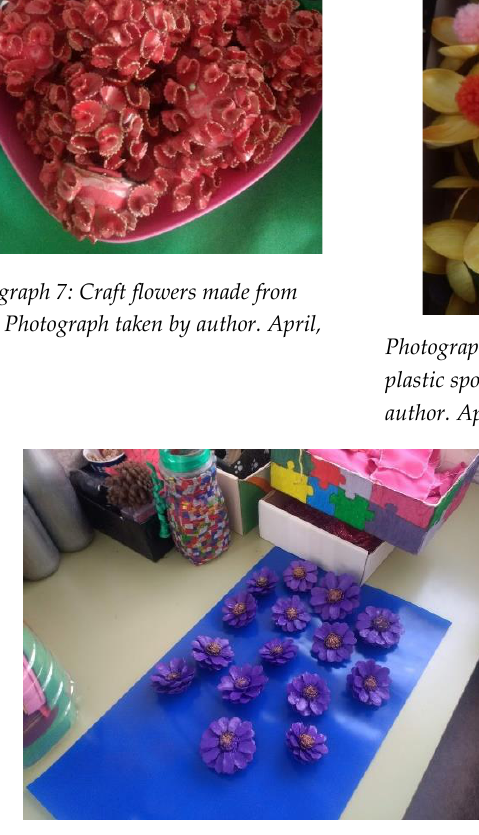
Photograph 10: Craft flowers from pine cones laid out for painting at the day centre. Photograph taken by author. February,